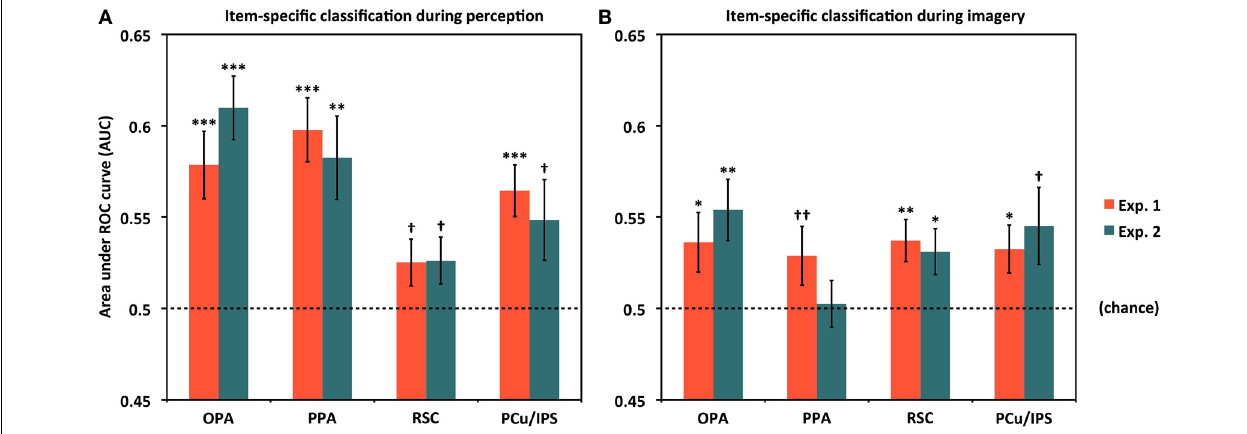
during mental imagery for Experiments 1 and 2. In all cases but PPA in Experiment 2, accuracies were significantly or near-significantly above chance. Analyses used 80 voxels per hemisphere per region, for a total of 160 voxels per region. ∗ p < 0 . 05, ∗∗ p < 0 . 01, ∗∗∗ p < 0 . 001, † p < 0 . 07, †† p < 0 . 10. Error bars represent s.e.m. See text and Table 1 for full